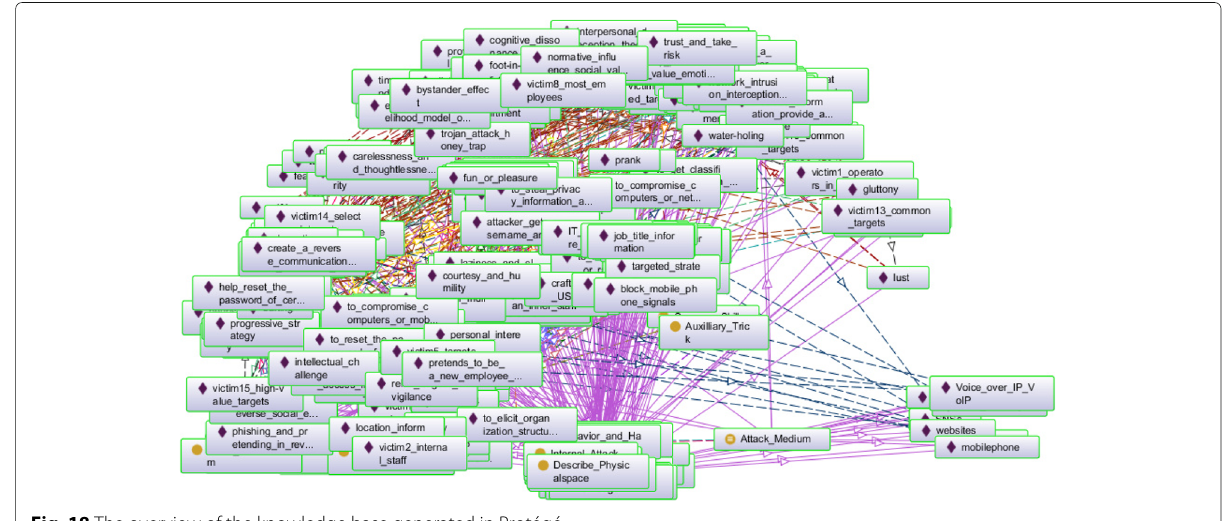
Fig. 18 The overview of the knowledge base generated in Protégé